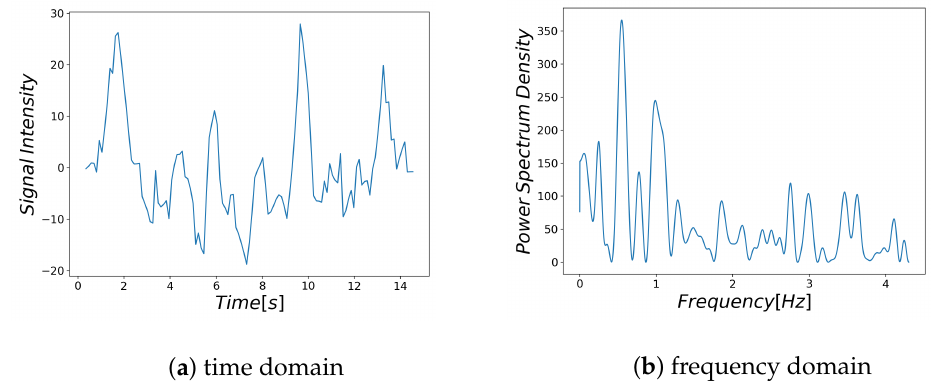
Figure 3. Respiratory-related signal: The signal extracted from the segmented region near the nose and its spectrum.